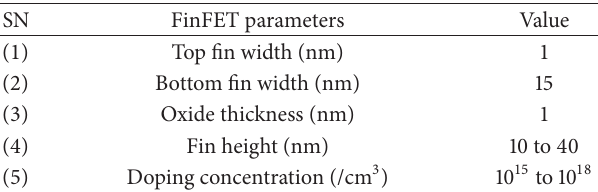
Table 1: Geometry of designed